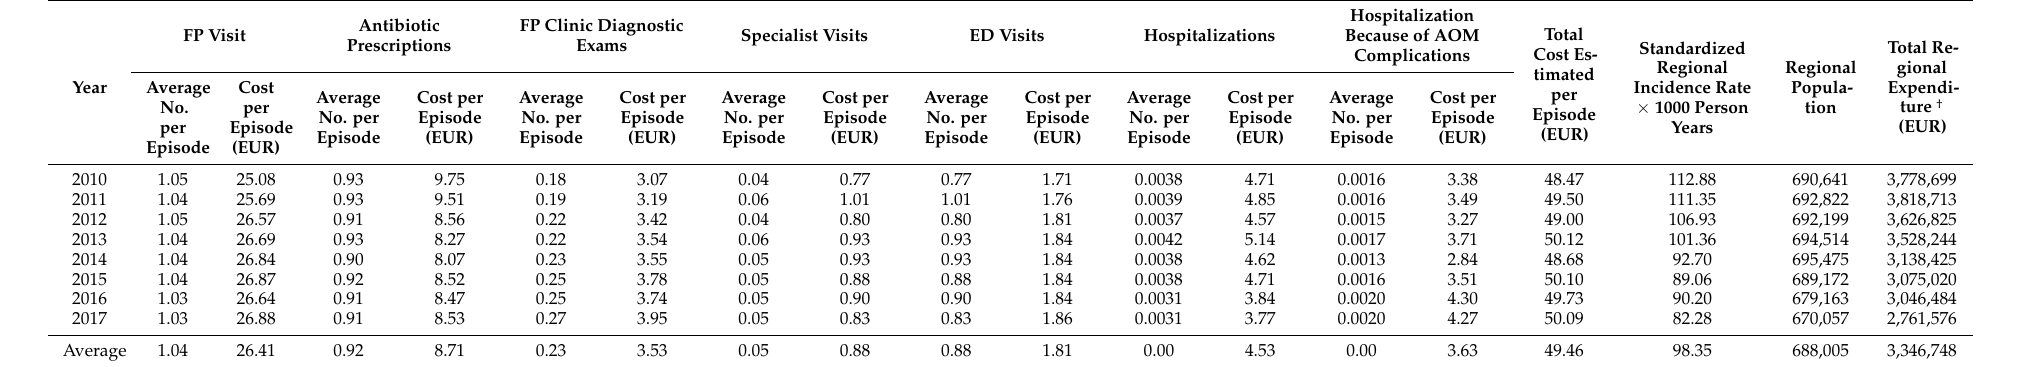
Table 6. AOM HCRU and related costs ( N = 41,683, Pedianet